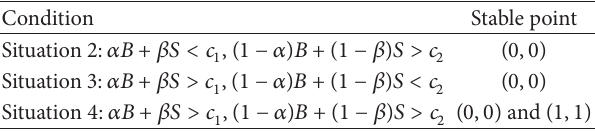
Table 2: Results of the stability judgment of Situation 1.